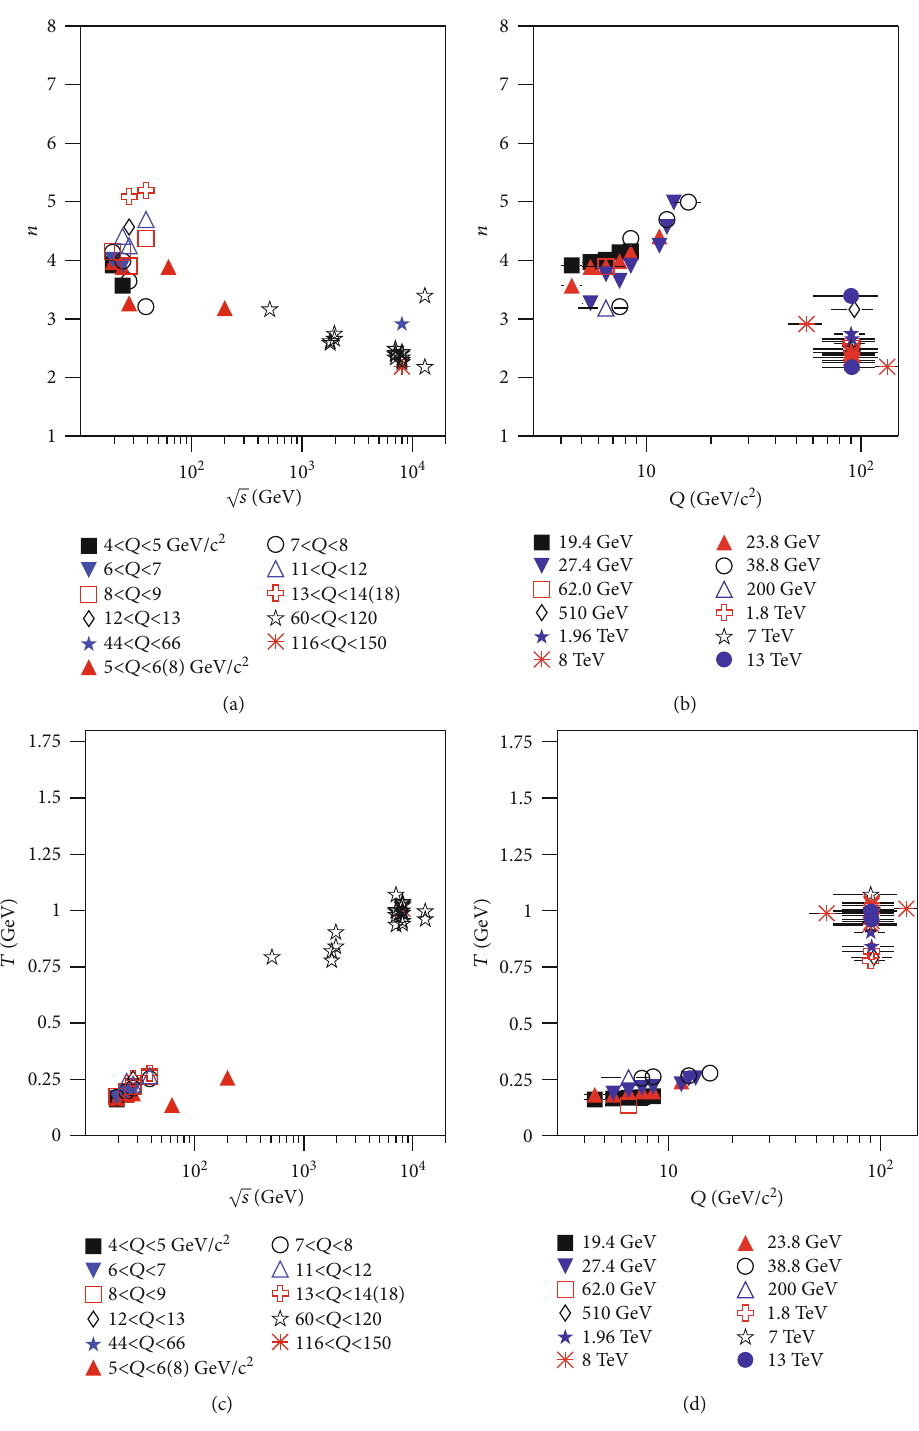
Figure 5: The variation of parameters n (a, b) and T (c, d) in the Lévy-Tsallis function with energy parameter values are taken from Figures 1 – 4 and recorded in Tables 1 and 2. Since the invariant mass grouping in Figure 1(e) is di ff erent from others, and the varying quantity in Figure 1(f) is the Feynman variable, Figure 5 does not include the parameters from Figures 1(e) and 1(f) to avoid